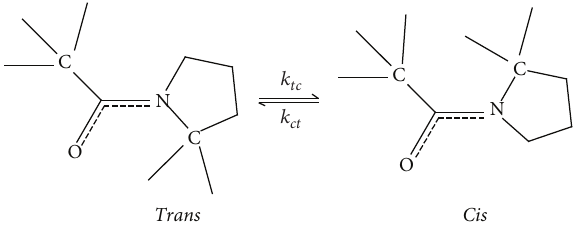
F 3: Trans- and cis- isomers of a peptidyl-prolyl peptide bond. Reprinted with permission from [110] ©2009 American Chemical